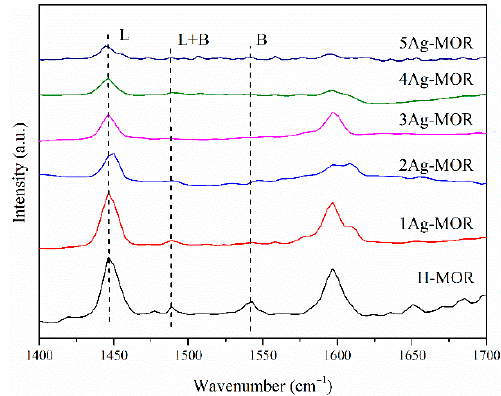
Figure 8. Py ‐ IR spectra of the catalysts. Figure 8. Py-IR spectra of the catalysts. Table 4. The distribution of acid sites of